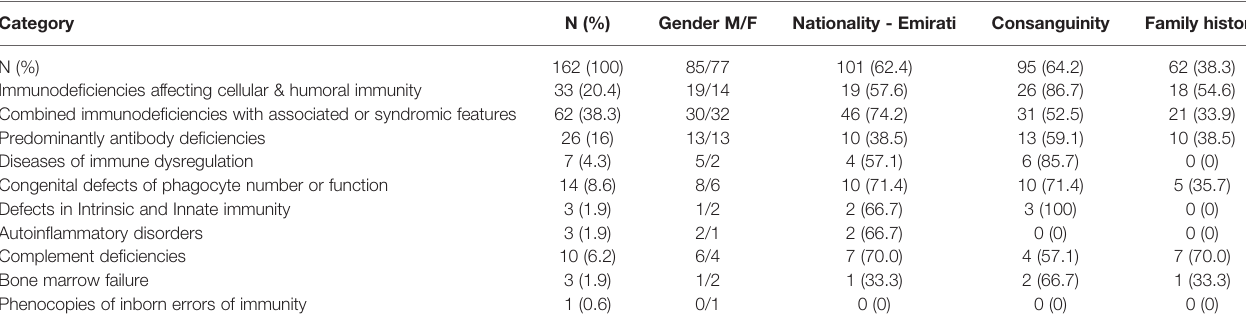
TABLE 1 | Characteristics of 162 UAE patients with IEI.